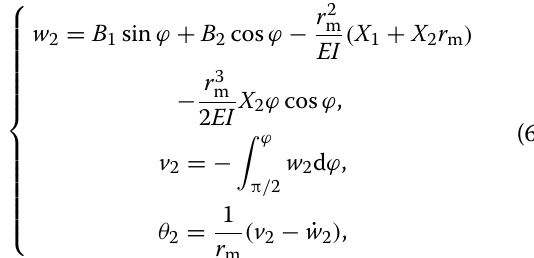
(a) Forces inside the wrapping angle